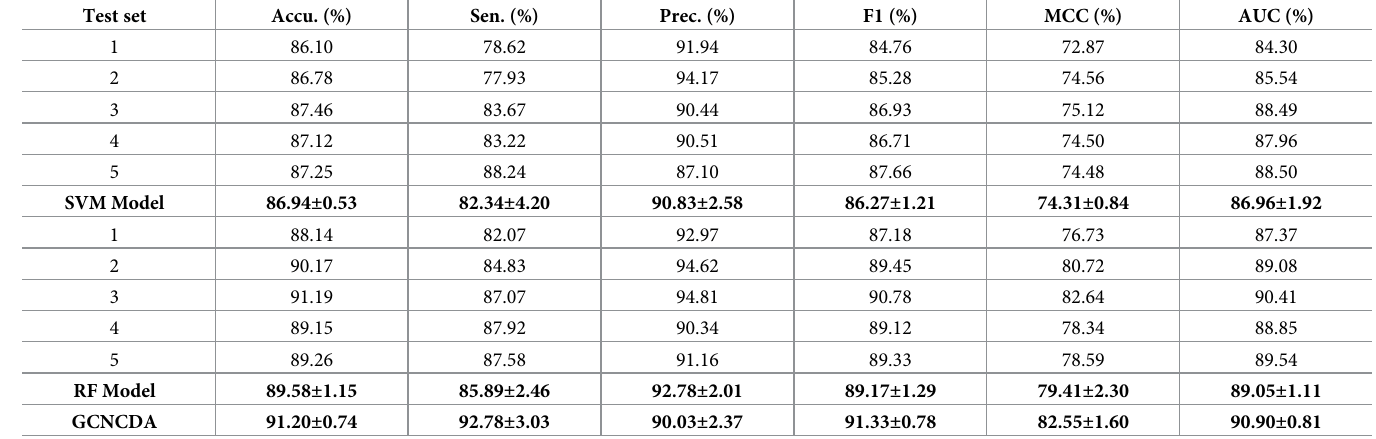
Table 2. Results of 5-fold CV generated by SVM model and RF model on circR2Disease dataset. Test set